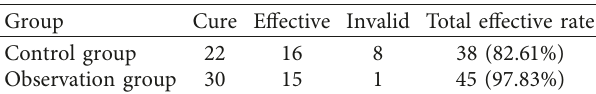
Figure 3: Analysis of the treatment of knee arthritis. Table 1: Comparison of clinical treatment effect between the two groups.